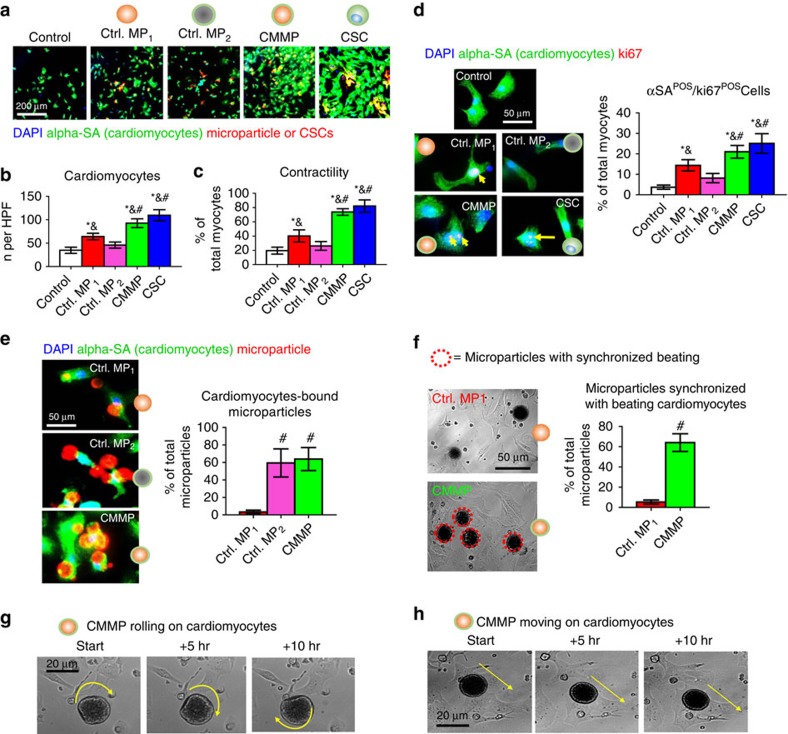
Effects of CMMPs on NRCMs functions in vitro.(a) Representative images of cardiomyocytes stained with alpha sarcomeric actin (green) co-cultured with Control MP1, Control MP2, CMMPs or CSCs (red). Scale bar, 200 μm. (b) Quantitative analysis reflected that Control MP1 (red bar) increased the numbers of NRCMs as compared with those from Control MP2 (pink bar) or solitary NRCM culture (white bar), but the greatest NRCM numbers were seen in those co-cultured with CMMPs (green bar) and genuine CSCs (blue bar). n=5 for each group. (c) Higher NRCM contractility was seen in those cultured with CMMPs (green bar) and CSCs (blue bar) compared with those cultured with Control MP1 (red bar). n=5 for each group. (d) Representative images and quantitative analysis of NRCMs stained with alpha sarcomeric actin (green) and proliferation marker Ki67 (red), treated with Control MP1, Control MP2, CMMPs or CSC. n=5 for each group. Scale bar, 50 μm. (e) Representative images and quantitative analysis of CMMP (red) or Control MP1 (red), Control MP2 (red) binding to NRCMs (green). n=3 for each group. Scale bar, 50 μm. (f) Representative movie screenshots and quantitation of Control MP1’s and CMMP’s synchronized movement with adjacent beating cardiomyocytes. n=3 for each group. Scale bar, 50 μm. (g,h) Time-lapse imaging revealed the rolling (g) and travelling (h) of CMMPs on attached cardiomyocytes. Yellow arrows indicated the rolling or moving directions. Scale bar, 20 μm. All data are mean±s.d. * indicates P<0.05 when compared with Control group; # indicates P<0.05 when compared with Control MP1 group; & indicated P<0.05 when compared with Control MP2. Comparisons between any two groups were performed using two-tailed unpaired Student’s t-test. Comparisons among more than two groups were performed using one-way ANOVA followed by post hoc Bonferroni test.